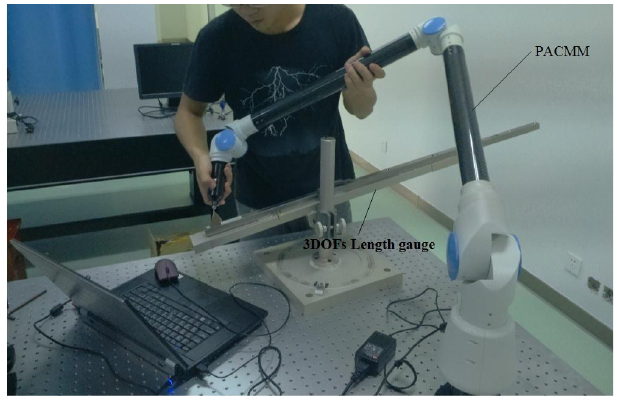
Figure 6. Sampling procedure.